Question: Provide a one-line summary of what is displayed.
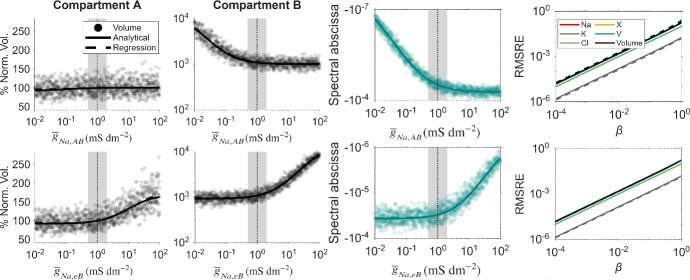
Answer: A comparison of the steady-state values of the volumes and corresponding spectral abscissa are shown as functions of \documentclass[12pt]{minimal} \usepackage{amsmath} \usepackage{wasysym} \usepackage{amsfonts} \usepackage{amssymb} \usepackage{amsbsy} \usepackage{mathrsfs} \usepackage{upgreek} \setlength{\oddsidemargin}{-69pt} \begin{document}$$\overline{g}_{Na,AB}$$\end{document} g ¯ N a , A B (top) or \documentclass[12pt]{minimal} \usepackage{amsmath} \usepackage{wasysym} \usepackage{amsfonts} \usepackage{amssymb} \usepackage{amsbsy} \usepackage{mathrsfs} \usepackage{upgreek} \setlength{\oddsidemargin}{-69pt} \begin{document}$$\overline{g}_{Na,eB}$$\end{document} g ¯ N a , e B (bottom). Varying these conductances has little effect on concentrations and voltage (not shown). GP regressions overlap with analytical steady states (color figure online)